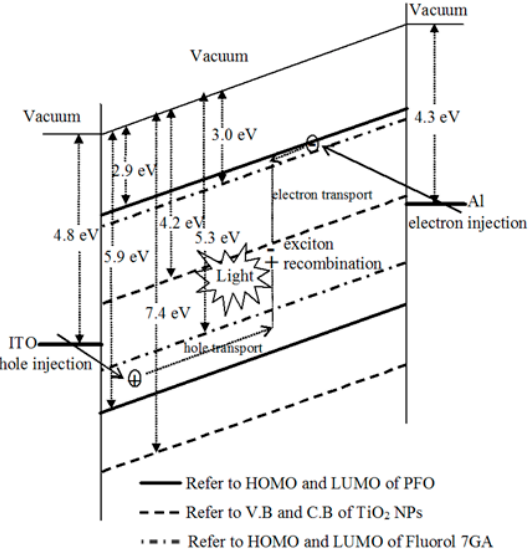
Figure 3. Energy band diagram for Al/PFO:Fluorol 7GA:TiO 2 /ITO OLED device relative to vacuum.